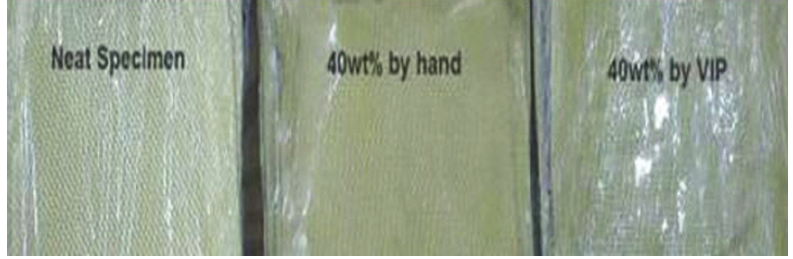
Figure 6 Three types of specimens made with two